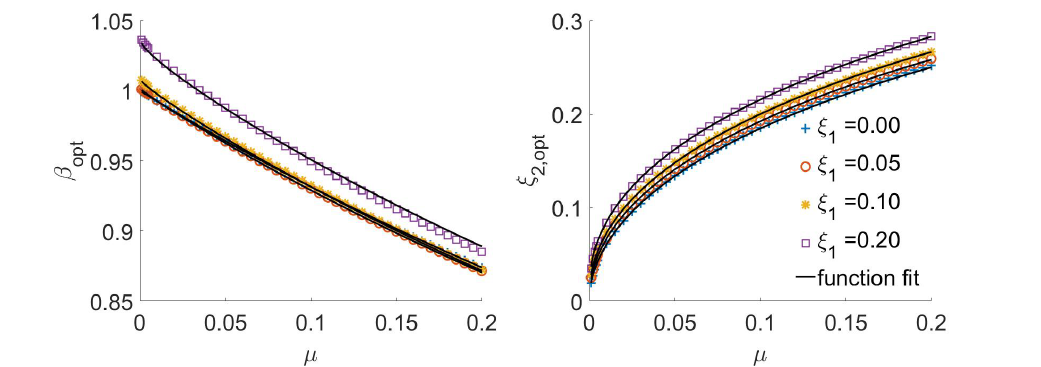
Figure 8. Optimum TMD parameters: TF No.